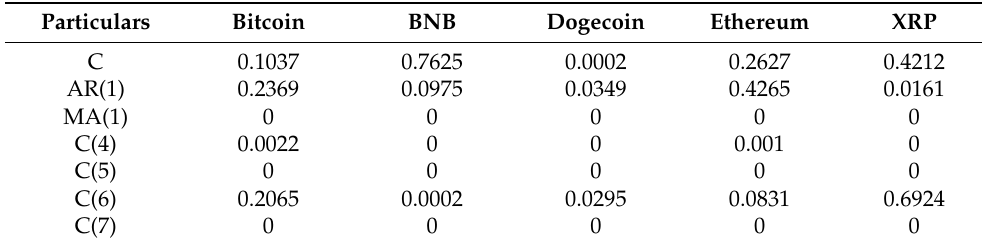
Table 6. E − GARCH: p -values of Return.